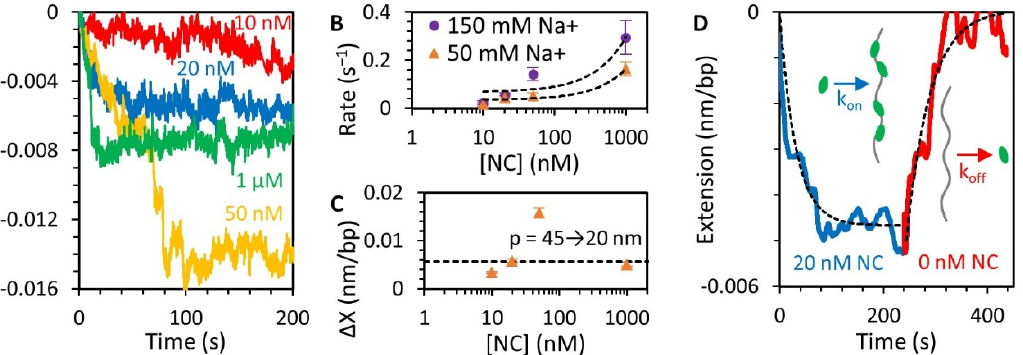
Figure 4. NC binding to DNA above force plateau (Figure 3, step 2). ( A ) Incubation of NC with DNA held at 20 pN results in a small concentration-dependent reduction in DNA extension. Low concentrations of NC (10 nM) result in slow and incomplete shortening of the DNA. At